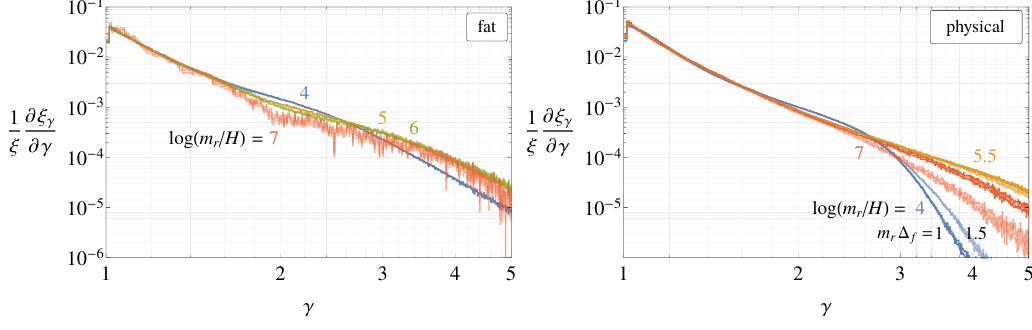
d ξ γ for fat strings (already ex- ξ d γ ∆ = 1 has the darker color, r f